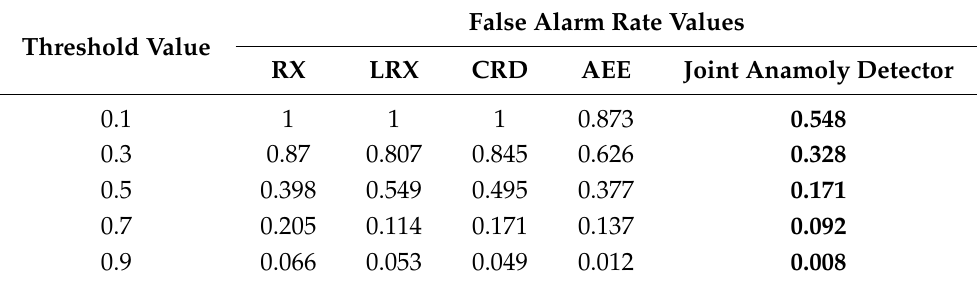
Table 3. The FPR values of different methods with some certain thresholds for effectiveness evaluation of joint anomaly detector.